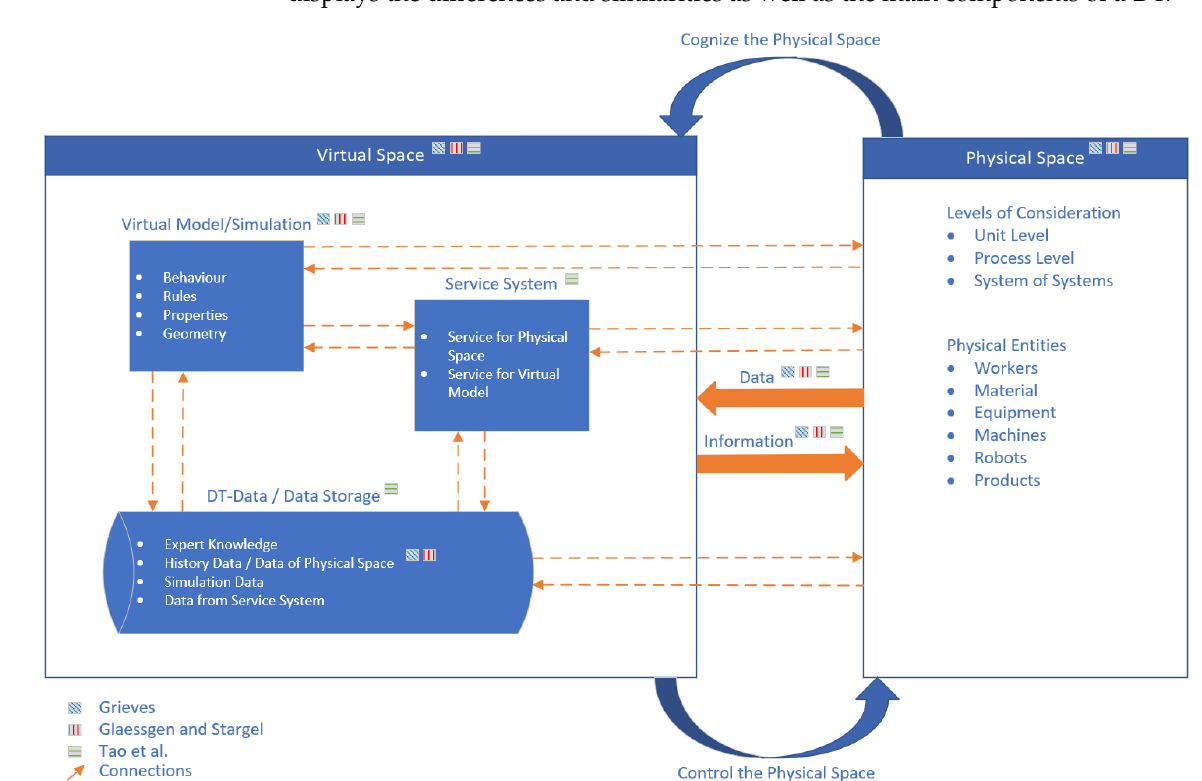
Figure 8. Digital Twin components [10,13,20,49].